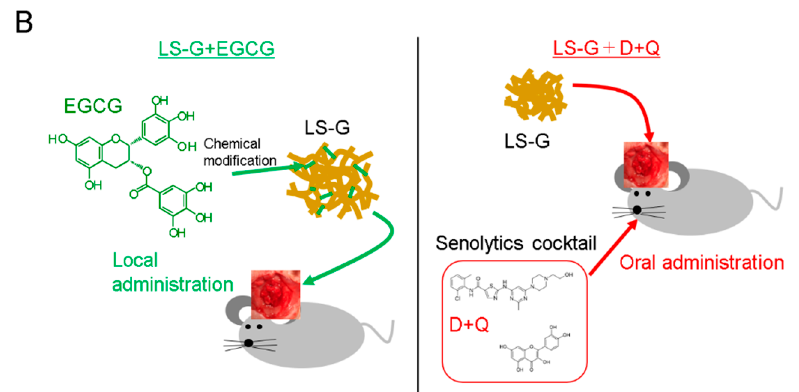
Figure 1. Flowchart of animal experiments: ( A ) workflow of animal experiments; and ( B ) schematic chart of LS-G+EGCG and LS-G+D+Q. CSBD, critical-sized bone defect; D, dasatinib; Q, quercetin; OA, oral administration; LS-G, implantation of lipopolysaccharide sustained-release gelatin sponges in bone defects; LS-G+EGCG, implantation of LS-G chemically modified with EGCG in bone defects; LS-G+D+Q, oral administration of senolytics (D+Q) with implantation of LS-G in bone defects.